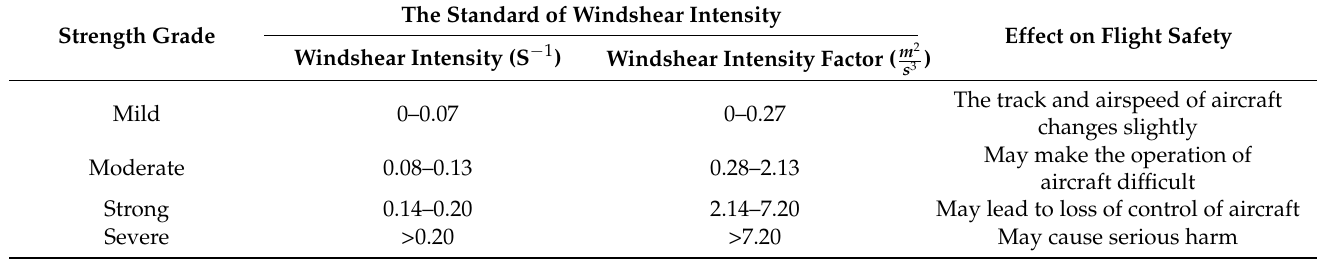
Table 1. The standard of wind shear intensity and its corresponding wind shear intensity factor value recommended by ICAO.